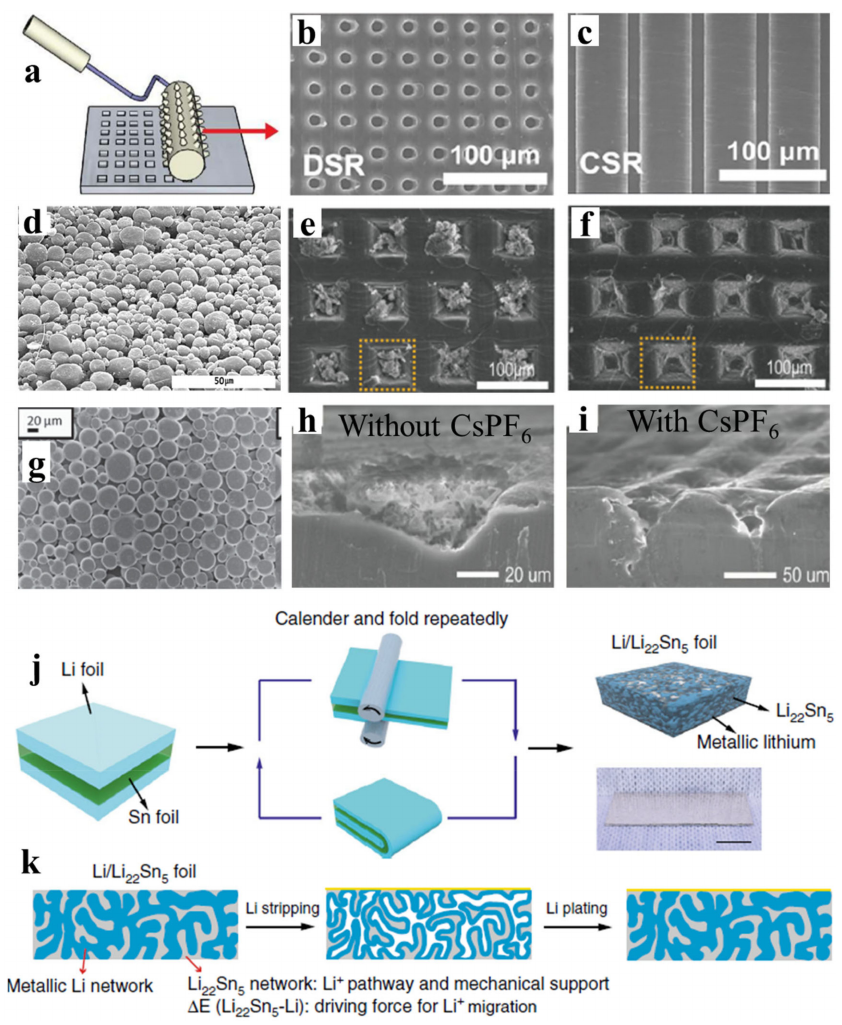
Figure 1. Micropattern preparation process and Li deposition morphology on porous Li. ( a ) Schematic demonstration of the microneedle technique. Reproduced with permission from [17], John Wiley and Sons, 2014. ( b , c ) SEM images of continuous surface relief (CSR) and discontinuous surface relief (DSR) on the Li electrode. Reproduced with permission from [18], American Chemical Society, 2019. ( d )